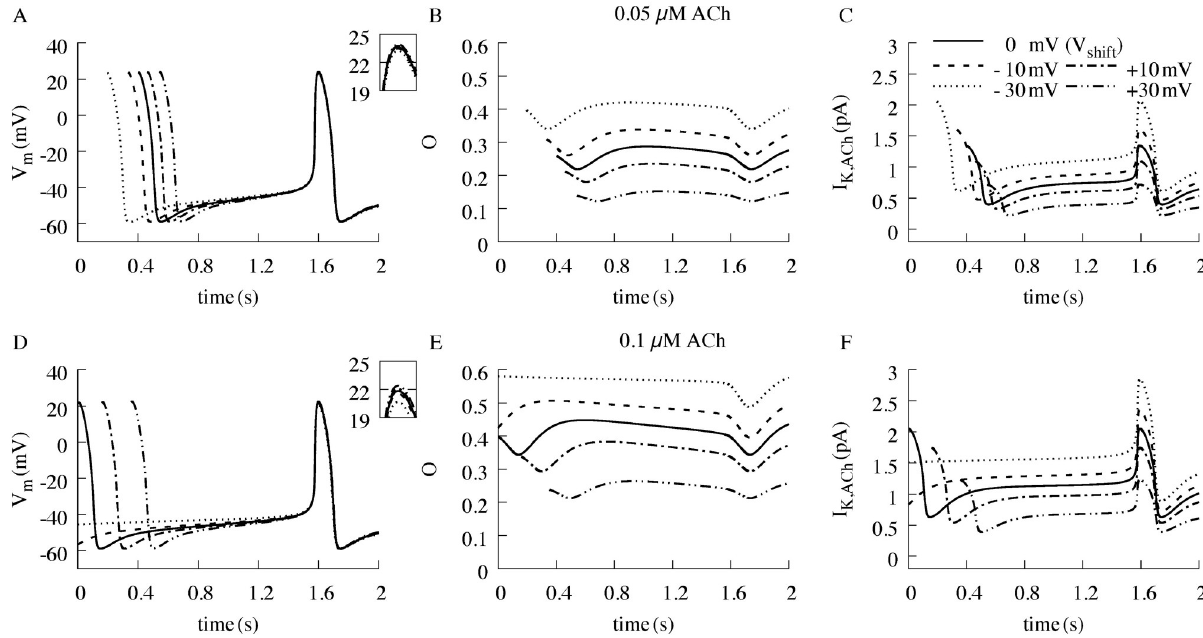
Fig 4. Effect of positive and negative voltage shifts of the M2R on the I K , ACh . In the presence of (A,B,C) 0.05 μ M ACh and (D,E,F) 0.1 μ M ACh. (A, D) present the resulting sinus node APs, (B,E) the open probability O of the K ACh channel and (C,F) the resulting I